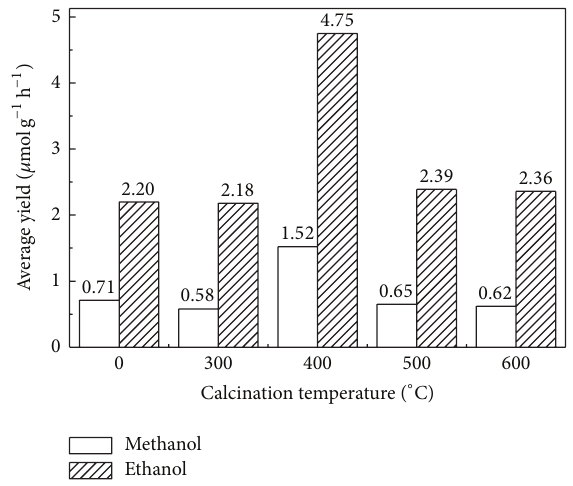
Figure 10: Photocatalytic activities of 5wt.% Co 3 O 4 /CeO 2 under different calcination temperature (the sample without calcination is denoted as